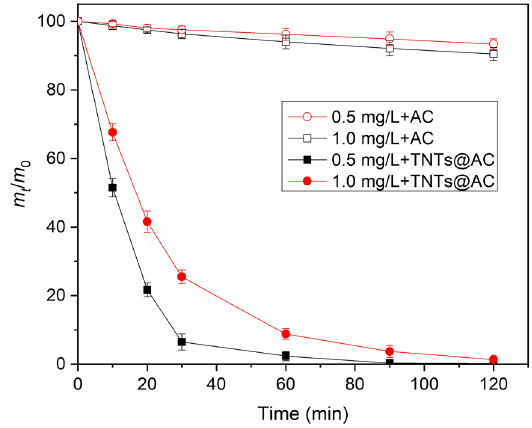
Figure 4. Photo-degradation kinetics of adsorbed E2 by activated charcoal (AC) and TNTs@AC. (Initial E2 concentration = 0.5 or 1.0 mg / L, material dosage = 0.5 g / L, temperature = 25 ± 0.2 ◦ C, volume of solution = 40 mL, solution pH = 7.0 ± 0.2).